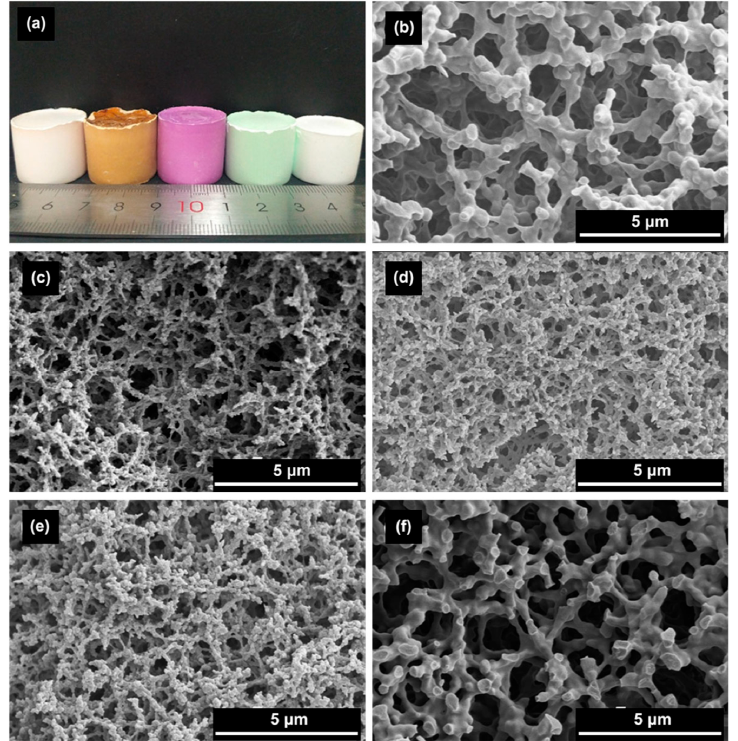
Figure 17. ( a ) Appearance of typical xerogel transition metal hydroxide monoliths. Corresponding SEM photomicrographs exhibiting the monoliths´ microstructure, derived from precursors of following low-valence elements: ( b ) Mn 2+ , ( c ) Fe 2+ , ( d ) Co 2+ , ( e ) Ni 2+ , and ( f ) Zn 2+ , respectively. Reprinted from the open access paper by F. Liu, D. Feng, H. Yang, X. Guo, “Preparation of macroporous transition metal hydroxide monoliths via a sol-gel process accompanied by phase separation.”, Sci. Rep.